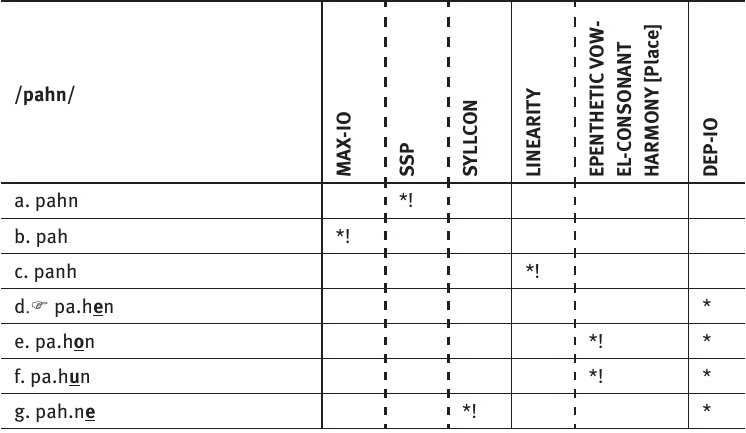
Table 7: MAX-IO>>SSP>>SYLLCON>>LINEARITY, EPENTHETIC VOWEL-HARMONY [Place]>>DEP-IO